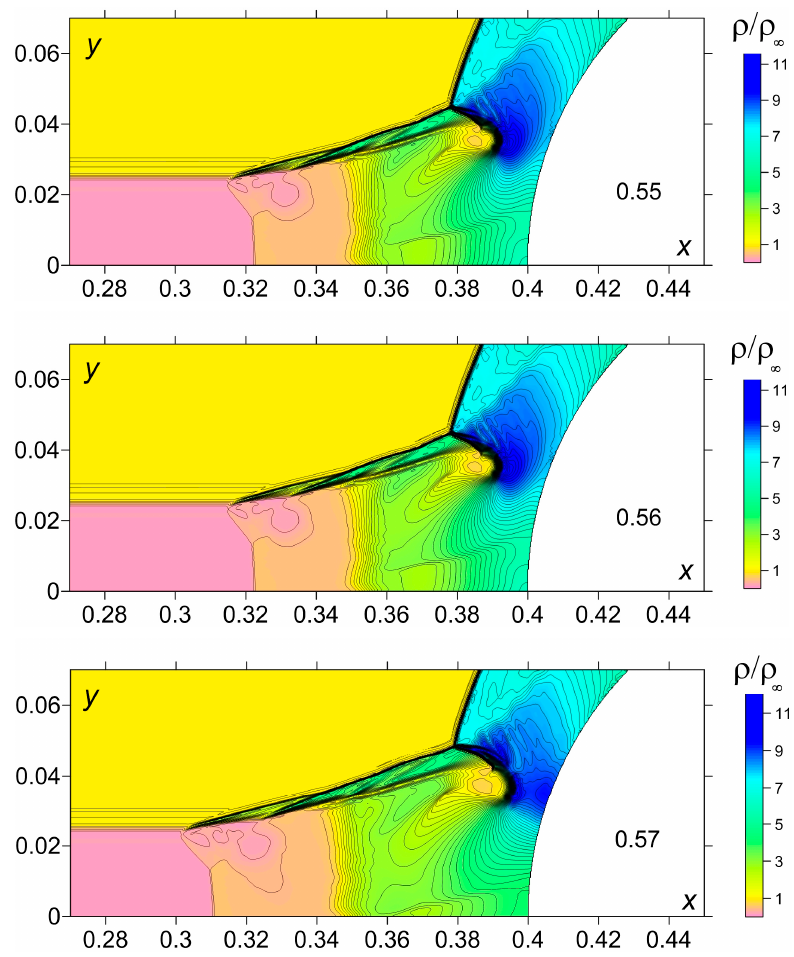
Figure 11. Dynamics of the formation of shock structure. Density (colors and isochors), M = 4, γ = 1.1, α ρ = 0.117 ( ω 1 = 19.33 o ), enlarged.